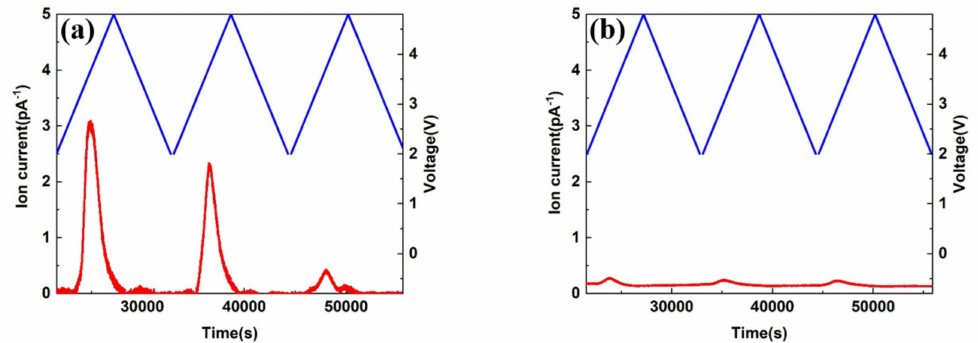
Figure 4. DEMS data of CO 2 released in different electrolytes during cycling. The blue and red lines correspond to the vertical axes of voltage and ion current respectively. ( a ) 1 M LiPF 6 EC/EMC/DMC and ( b )